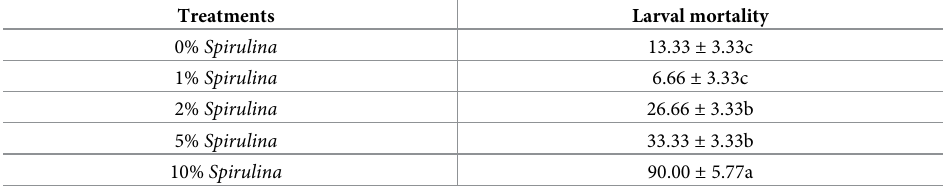
Means followed by the same letters do not differ significantly ( P < 0.05).